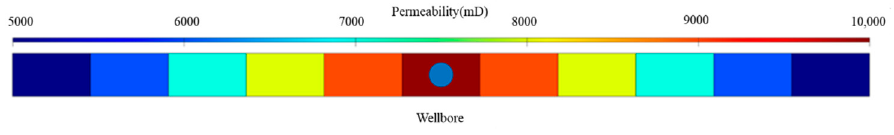
Figure 6. Variation of fracture aperture and permeability.